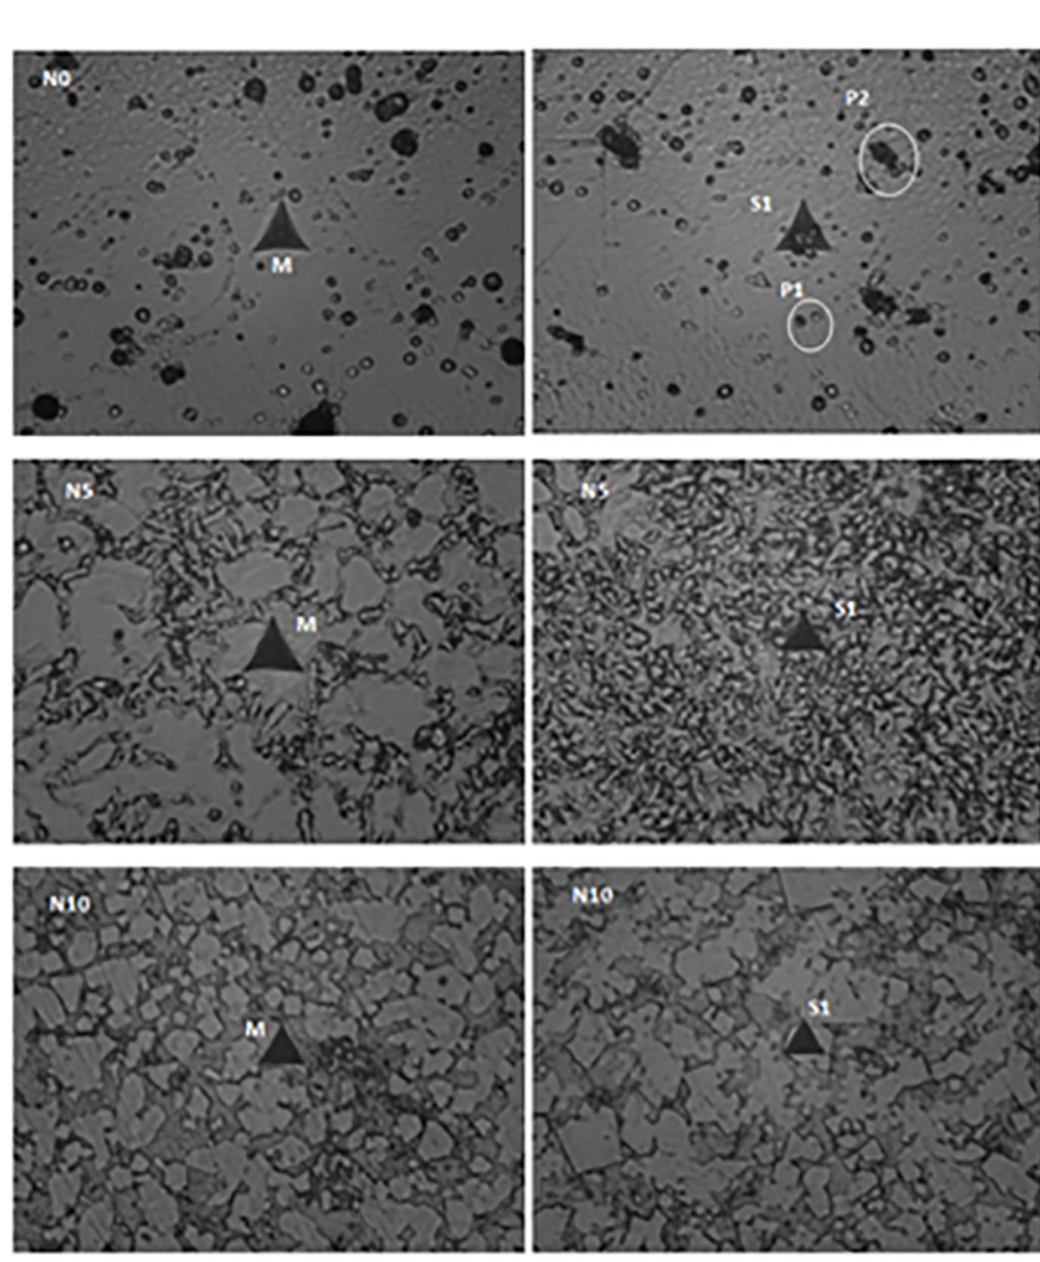
Figure 4. Indents made on the N0, N5 and N10 alloys. M: matrix, P1: precipitate light color, P2: precipitate dark color, S1: second